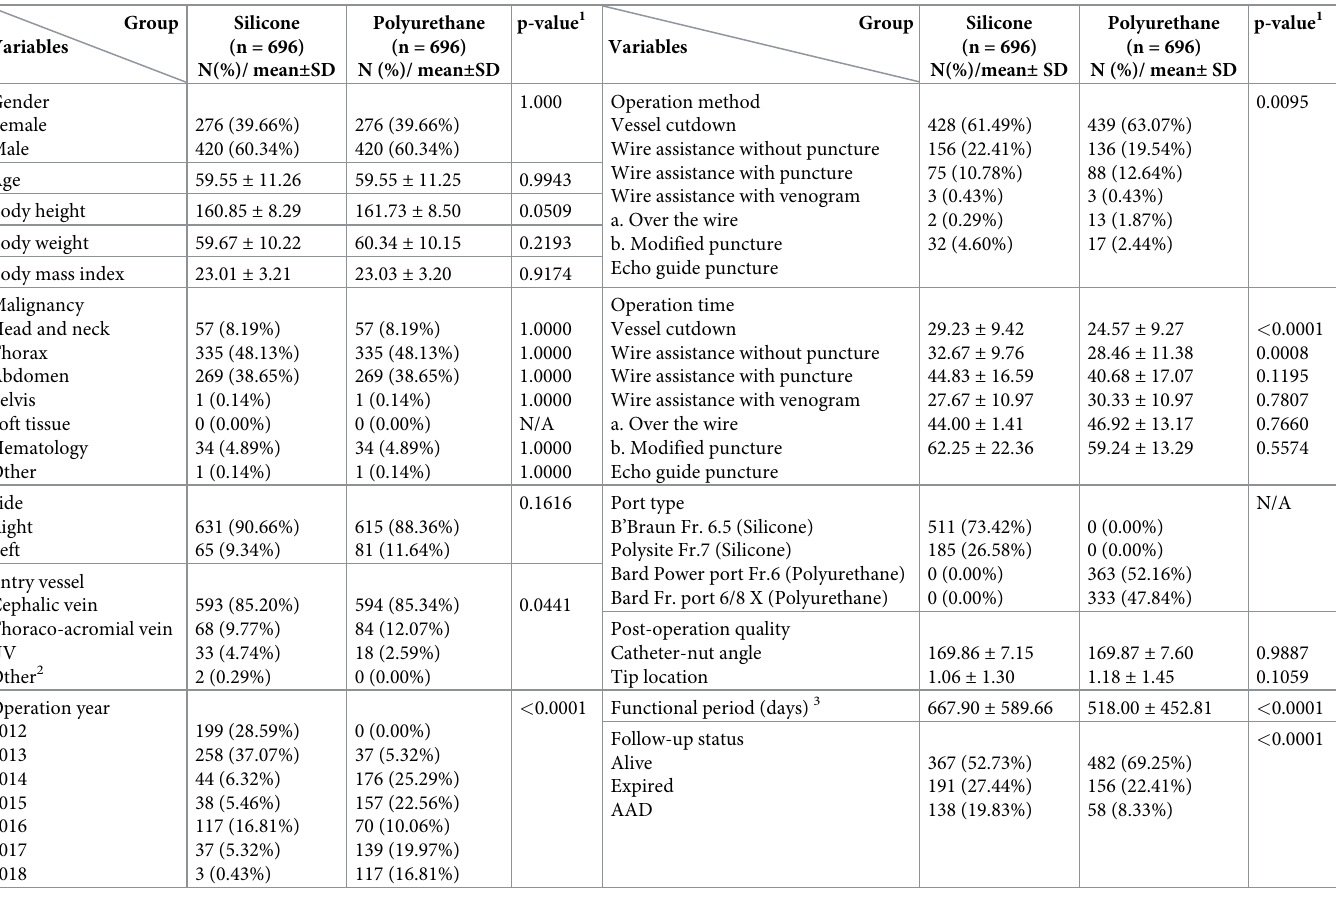
Table 1. Descriptive data of ports with silicone and polyurethane catheters (after